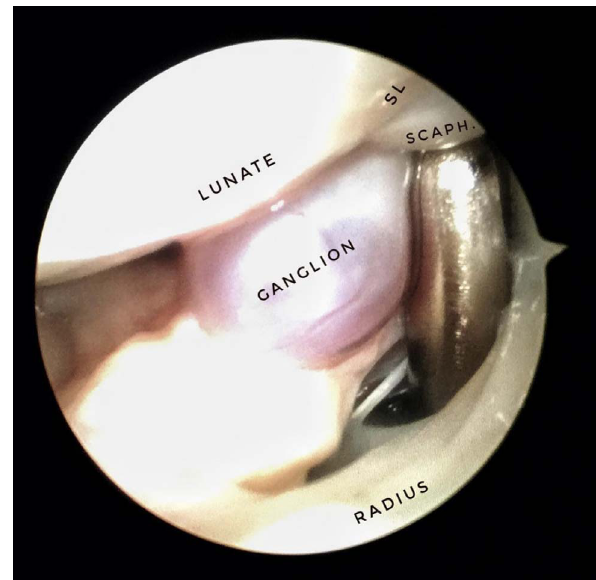
Figure 5. Arthroscopic view ganglion originates from the SL. Arthroscopic excision of ganglion cyst allows the surgeon to visualize the origin of ganglion and to remove it from inside while also avoiding scaring and ensuring that the origin is removed. Bene fi ts of the procedure include direct visualization of the articular surfaces and stability of the intrinsic ligaments, less surgical dissection, less postoperative pain, faster recovery, and earlier return to work and activities of daily living. SL, Scapho-lunate ligament; SCAPH, Scaphoid.